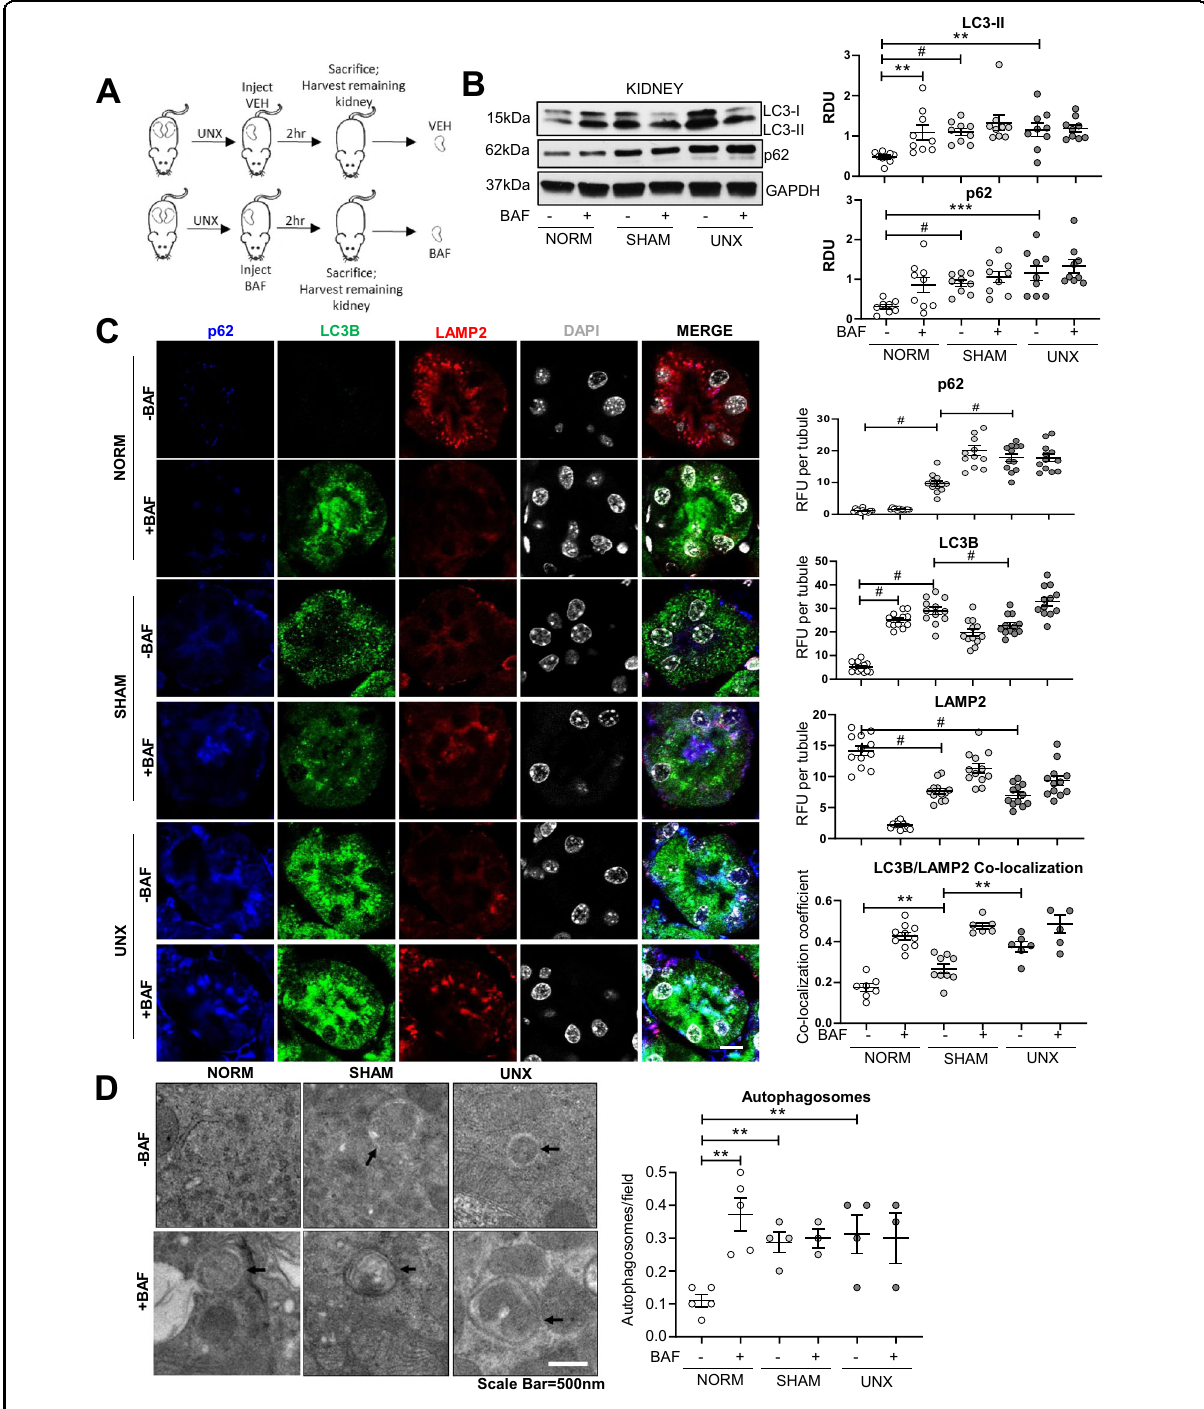
Fig. 4 Suppressed autophagic fl ux after sham surgery and UNX in the kidney. A Mice underwent either no surgical manipulations (NORM), sham surgery (SHAM), or unilateral nephrectomy (UNX). Each mouse was treated with either vehicle (VEH) or BafA1 (BAF) and after 2 h the contralateral kidney was harvested. B Immunoblot analysis of LC3-II and p62 in the kidney with representative densitometry is demonstrated ( n = 9 per group). Immunoblots were corrected for the endogenous control, GAPDH. RDU = relative densitometry units corrected for GAPDH. C Immuno fl uorescence analysis of punctate LC3B, LAMP2, and p62 per tubule in the kidney with quanti fi cation showing readings in duplicate for each mouse. RFU = relative fl uorescence units. D Transmission electron microscopy for autophagosomes with quanti fi cation is demonstrated (arrows = autophagosome). Autophagosomes are quanti fi ed per 10 µm 2 fi eld. Scale Bar = 500 nm. ** P < 0.01, *** P < 0.001, # P <